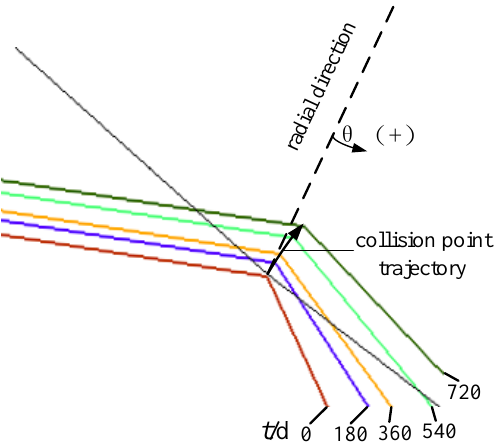
Figure 14. Collision point trajectory ( d p = 100 µ